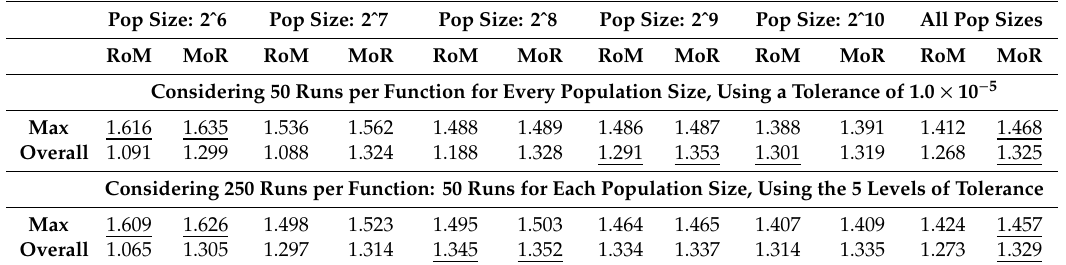
Table 8. General values of ratio of means (RoM) and mean of ratios